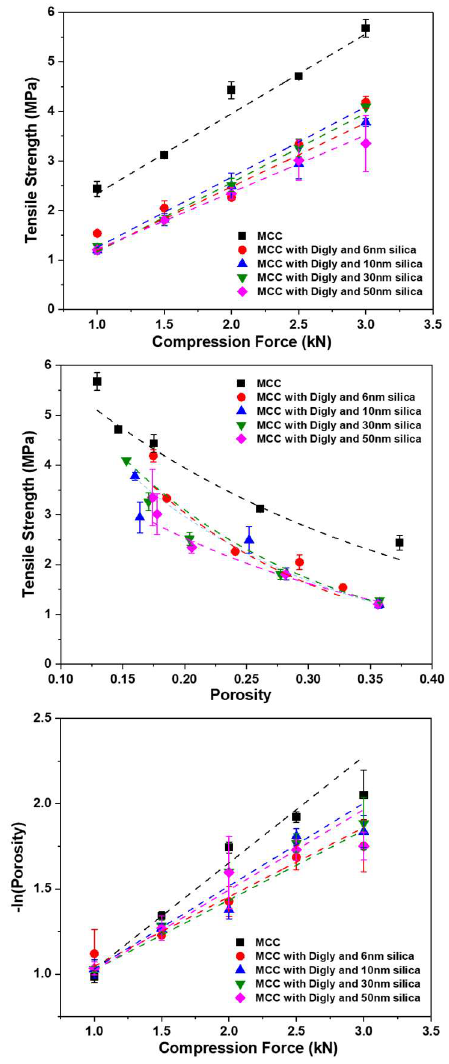
Figure 3. ( Top ) Tabletability, ( Middle ) compactability, and ( Bottom ) compressibility profiles of the 25% loading blend of diglycine–silica–MCC composite tablets prepared along with MCC alone (blue squares, PH101). Red circles, blue upwards triangles, green downwards triangles, and pink rhombuses represent diglycine crystallised using silica with pore sizes of 6 nm, 10 nm, 30 nm, and 50 nm as templates, respectively, with n ≥ 3 (n is the number of